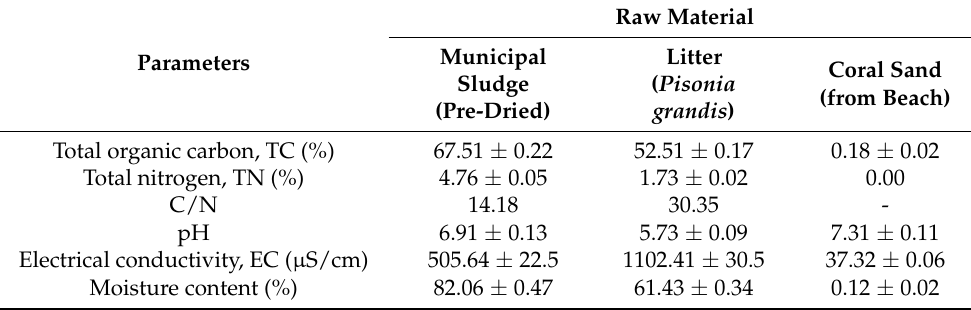
Table 1. Properties of the substrates 1